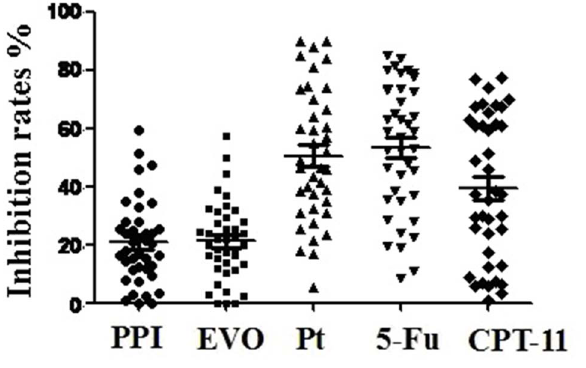
Figure 4. The inhibition rates of different agents on freshly- removed gastric cancer. The lines in the middle stood for mean with SEM; n=40.